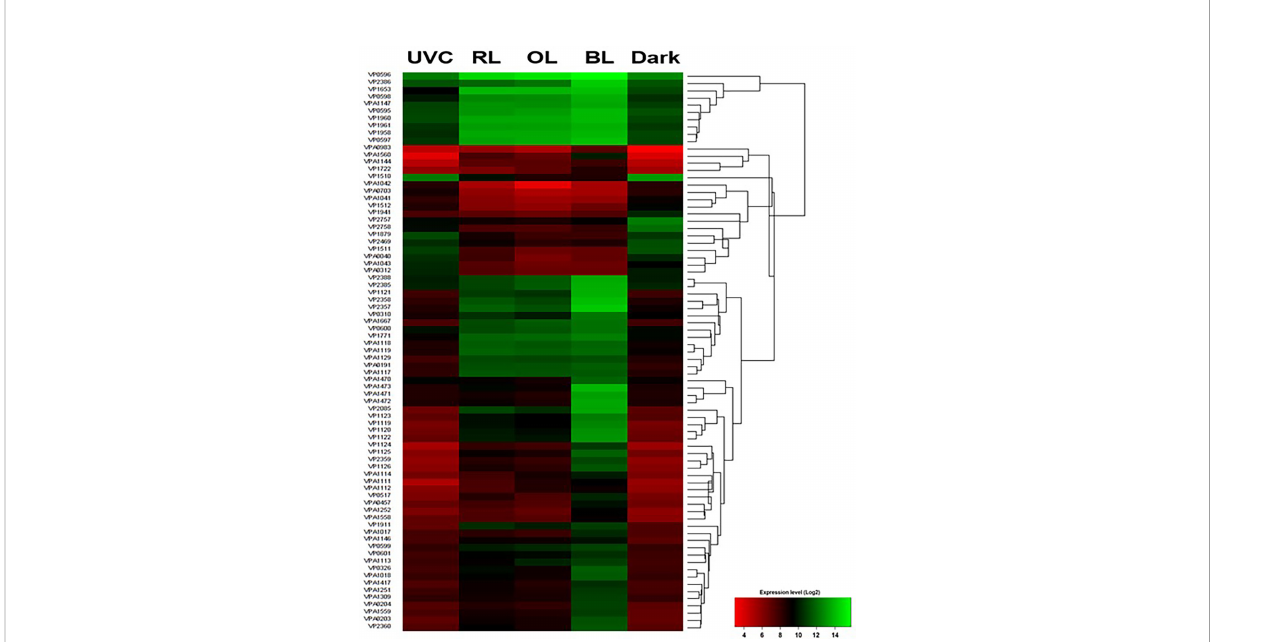
FIGURE 4 Heatmap of Set2B.DEGs. See Table S1 for gene product function. Expression levels are represented by color: green, higher expression level; red, lower expression level based on Log2 fold